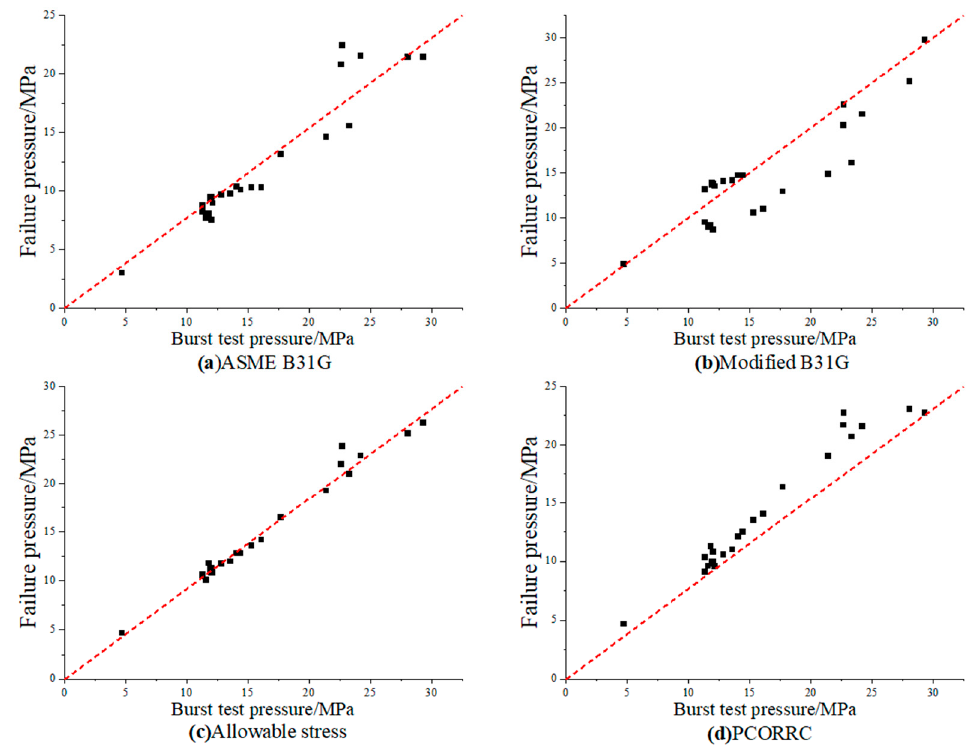
Figure 8. Comparison of burst pressure and predicted failure pressure of medium and high strength pipelines calculated by different methods: ( a ) ASME B31G; ( b ) Modified B31G; ( c ) Allowable stress; ( d ) PCORRC.